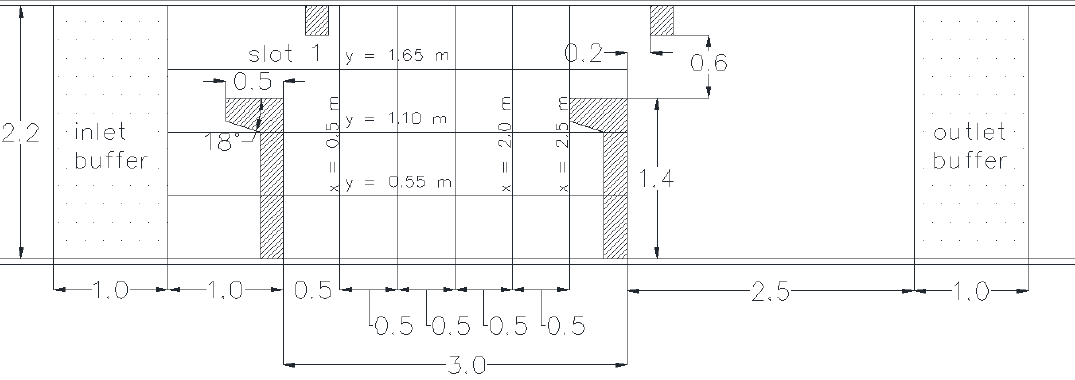
Figure 2. Plan view of the VSF, showing the coordinate system with a base at the corner of the pool, locations of observed cross sections x = 0.5 m, 1.0 m, 1.5 m, 2.0 m and 2.5 m, and profiles y = 0.55 m, 1.10 m, 1.65 m. Dimensions are in